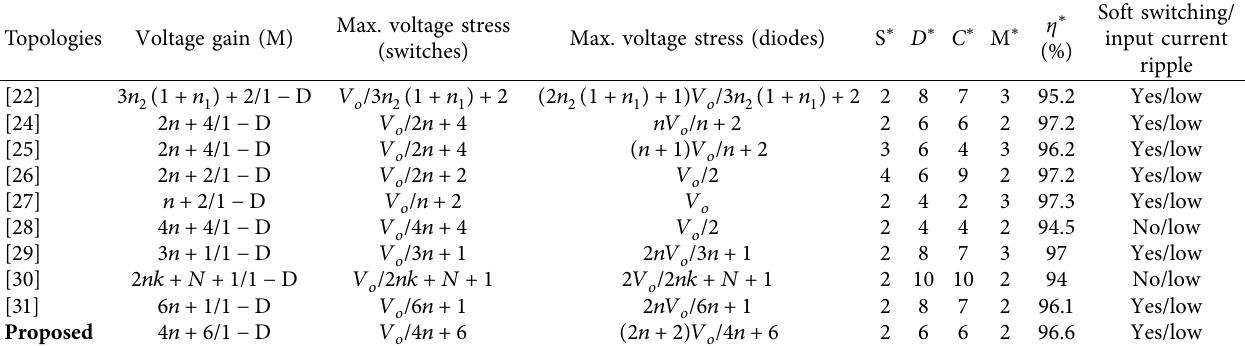
Table 2: Comparison of the proposed converter with other similar converters.